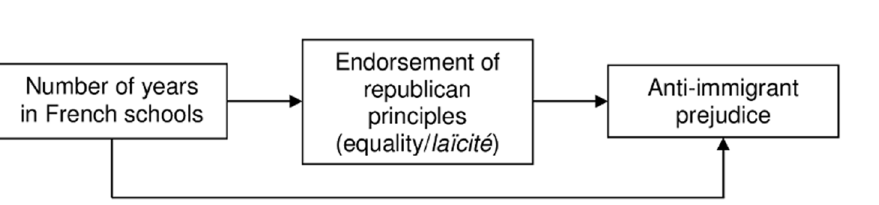
Figure 1. Model of the effect of formal schooling (number of years in schools) on prejudice (intergroup attitudes) as a function of the transmission of republican principles and